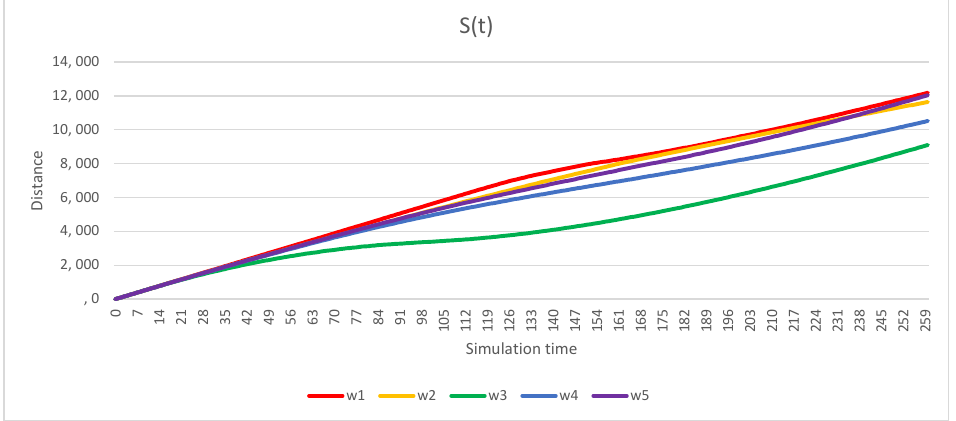
Figure 12. Change in distance traveled S ( t ) in simulation by context 3 for distance D 0 = D gr = 5000 m.